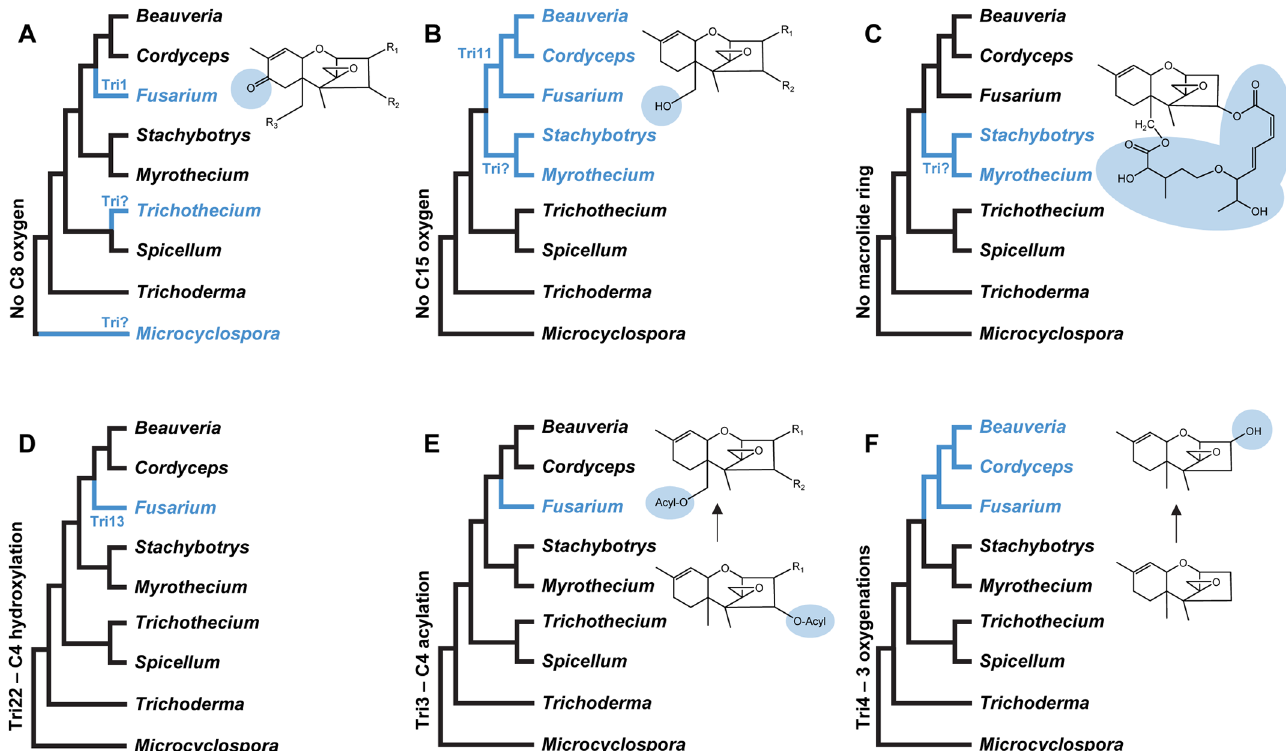
Fig 10. Scenarios for changes in trichothecene biosynthesis during evolutionary divergence of TRI cluster homologs. The scenarios presume the ancestral TRI cluster and trichothecene pathway presented in Fig 12. In each scenario, the tree is a simplified version of the tree inferred from concatenated sequences of TRI3 , TRI5 ,and TRI14 (Fig 3). A change in biosynthesis from the ancestral state is indicated by a change in color of a branch from black to blue. A. acquisition of C8 oxygen by gain of Tri1 in Fusarium and an unknown enzyme(s) in Microcyclospora and Trichothecium ; B. acquisition of C15 oxygen by gain of Tri11 in Fusarium , Beauveria and Cordyceps , and an unknown enzyme in Myrothecium and Stachybotrys ; C. acquisition of macrolide ring by gain of unknown enzymes in Myrothecium and Stachybotrys ; D. change in C4 hydroxylation enzyme from Tri22 to Tri13 during divergence of Fusarium TRI cluster; E. change in Tri3 function from C4 acylation to C15 acetylation during divergence of Fusarium TRI cluster; and F. change in Tri4 function from 3 to 4 oxygenations during divergence of TRI cluster lineage in Fusarium , Beauveria , and Cordyceps